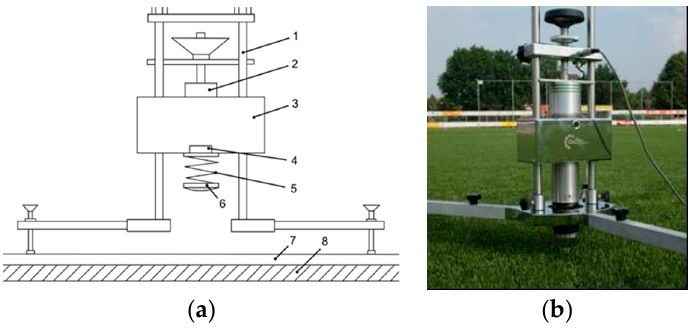
Figure 1. ( a ) schematic of the Advanced Artificial Athlete (AAA) [1]: 1. Support frame; 2. Electric magnet; 3. Falling mass; 4. Accelerometer; 5. Spring; 6. Test foot; 7. Test surface; 8. rigid floor; ( b ) photograph of the AAA